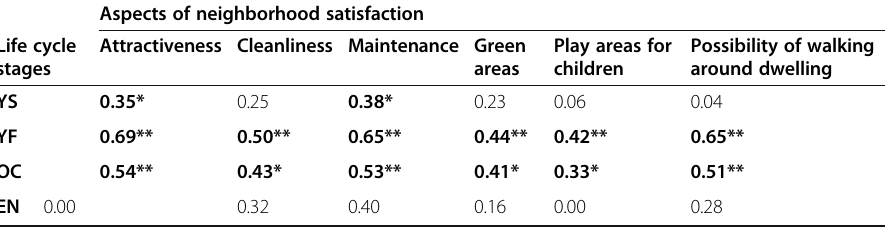
Table 7 Correlations between neighborhood satisfaction and its different aspects Aspects of neighborhood satisfaction